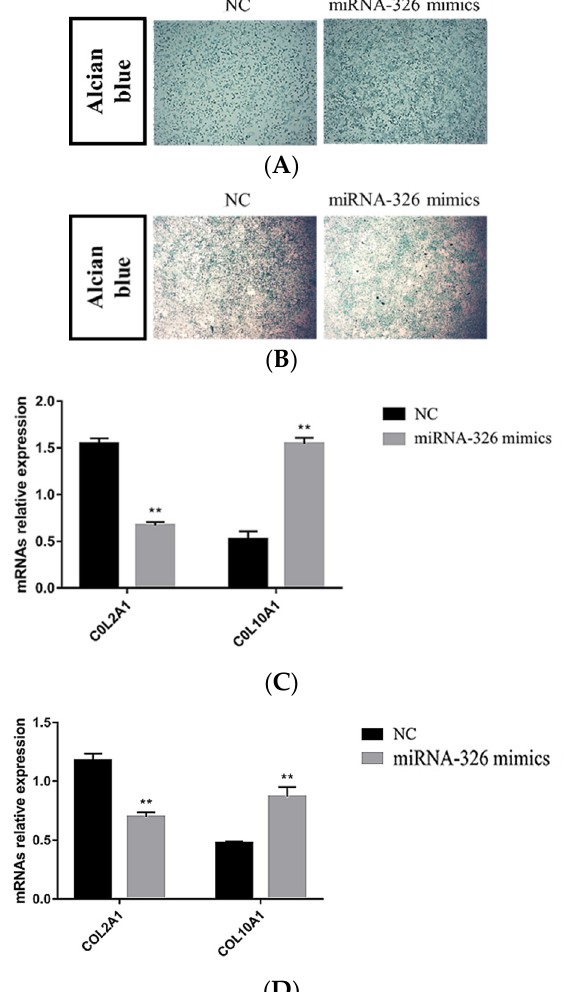
Figure 8. miRNA-326 promotes chondrocyte differentiation. ATDC5 cells ( A , C ) and pig primary chondrocytes ( B , D ) were cultured in chondrogenic differentiation media and transfected with NC or miRNA-326 mimics. After 4 days, the cultures were stained with Alcian blue or harvested for mRNA isolation and qPCR analyses of COL2A1 and COL10A1 and gene expressions. ** p < 0.01, Student’s t